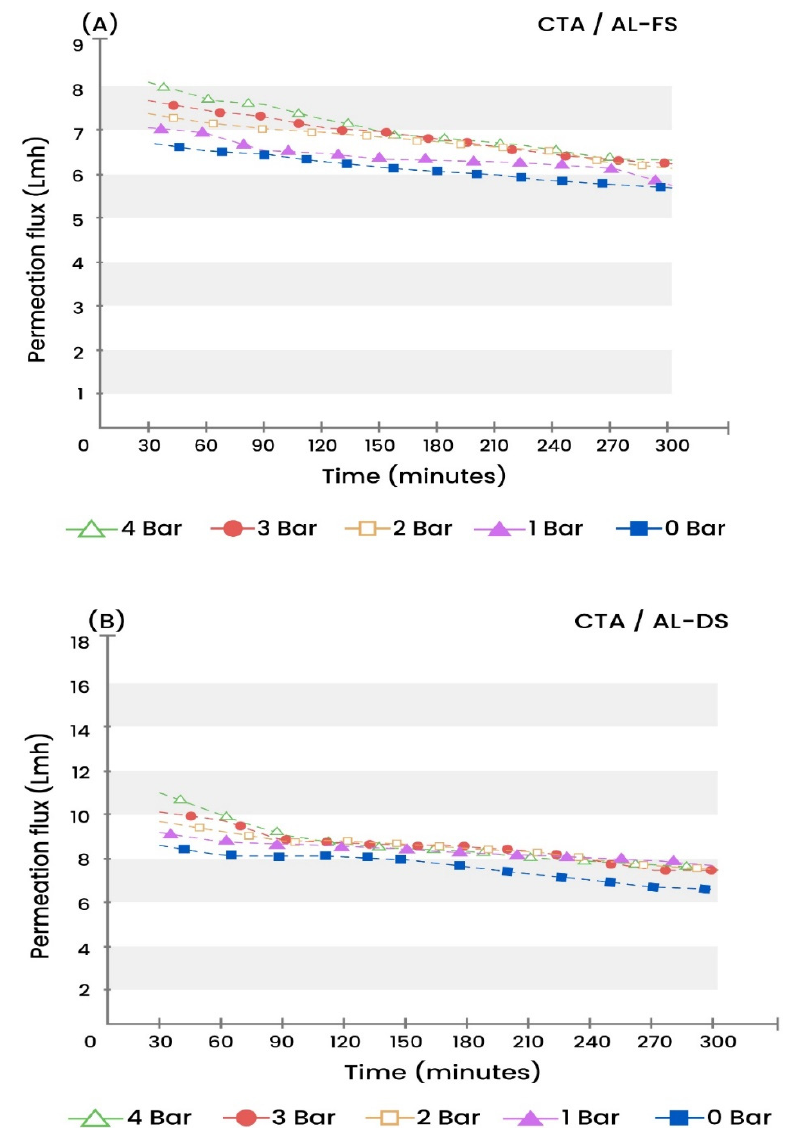
Figure 5. Change of permeation flux with time at different applied pressures using CTA membrane, ( A ) AL-FS and ( B ) AL-DS orientations.